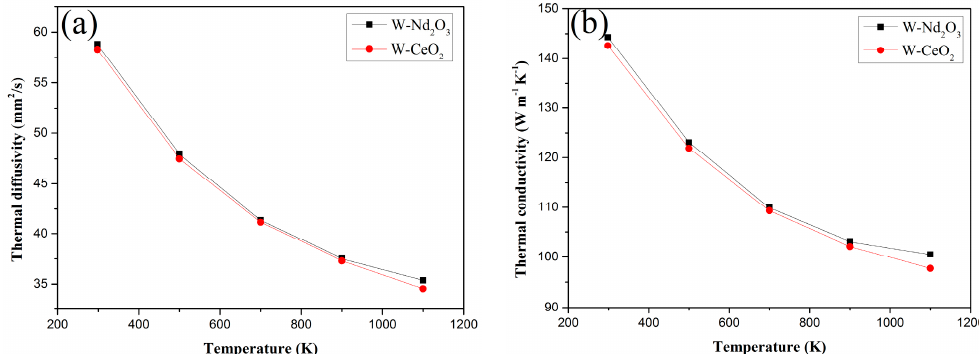
Figure 9. Thermal diffusivities and thermal conductivities versus temperature of W–1 wt % Nd 2 O 3 and W–1 wt % CeO 2 composites. ( a ) Thermal diffusivities; ( b ) thermal conductivities.